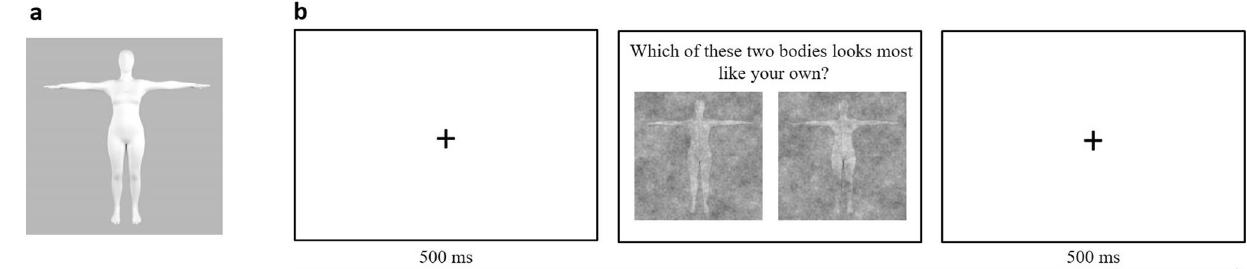
Figure 6. Base image and procedure. (a) Base image used for the reverse correlation paradigm. A sinusoidal noise pattern and its inverted noise pattern were superimposed on this base image, creating two perceptually opposing images. (b) Schematic overview of the experimental procedure. A fixation cross was presented for 500 ms, after which participants were asked to choose (with no time limit) between two images answering one of three questions: Which of these two bodies looks most like your own? (own abstract), Which of these two bodies looks most like the body you would like to have? (ideal), or Which of these two bodies looks most like the body you would use for online shopping? (own